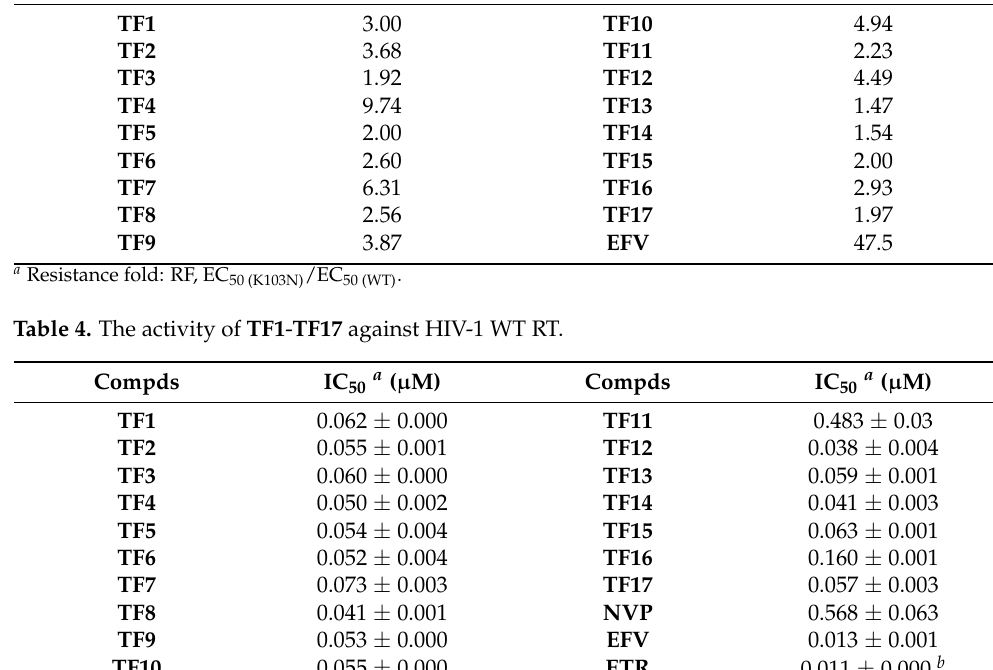
Table 3. Resistance fold for K103N mutant strain of TF1–17 . Resistance Folds a Resistance Folds a Compounds Compds K103N K103N TF1 3.00 TF10 4.94